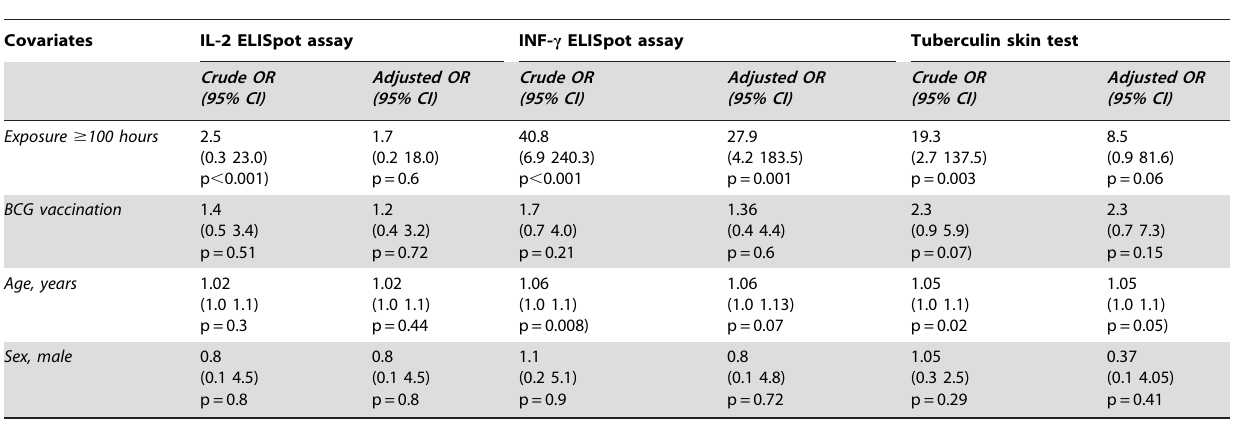
Table 2. Logistic regression analysis of the association of a positive interleukin (IL)-2 ELISpot assay, interferon (INF)- c ELISpot assay and tuberculin skin test with potential explanatory factors for the presence of positive results in tests for the immunodiagnosis of tuberculosis.